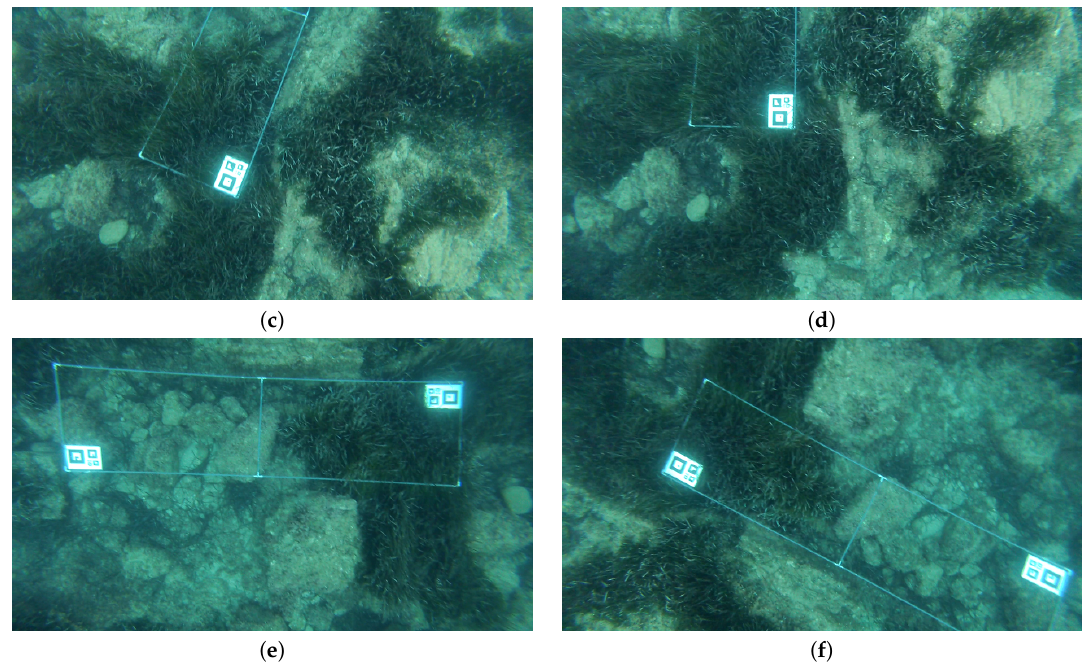
Figure 11. Multi-session loops between sequences V 3 and V 4: Each image in the left column closes a loop with the corresponding image in the right column. ( a , b ) Image 91 of Sequence V 3 with Image 155 of Sequence V 4. ( c , d ) Image 145 of Sequence V 3 with Image 174 of Sequence V 4. ( e , f ) Image 36 of Sequence V 3 with Image 183 of Sequence V 4